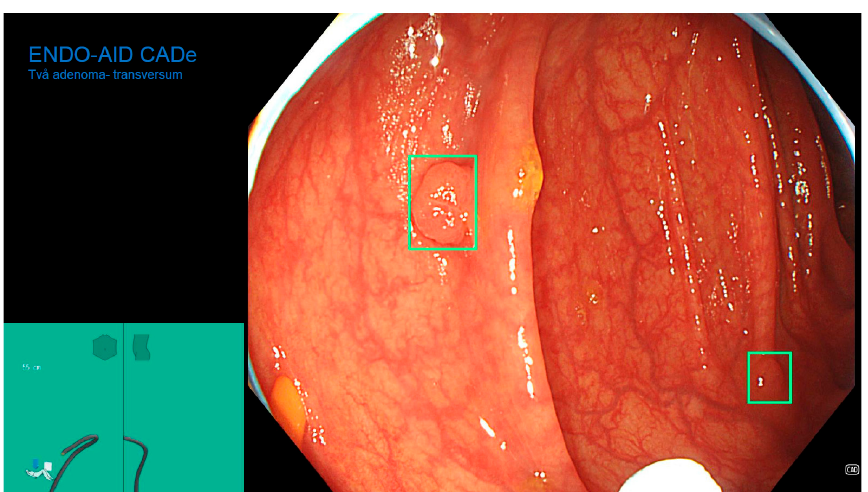
Figure 2. Two polyps detected by CADe AI .